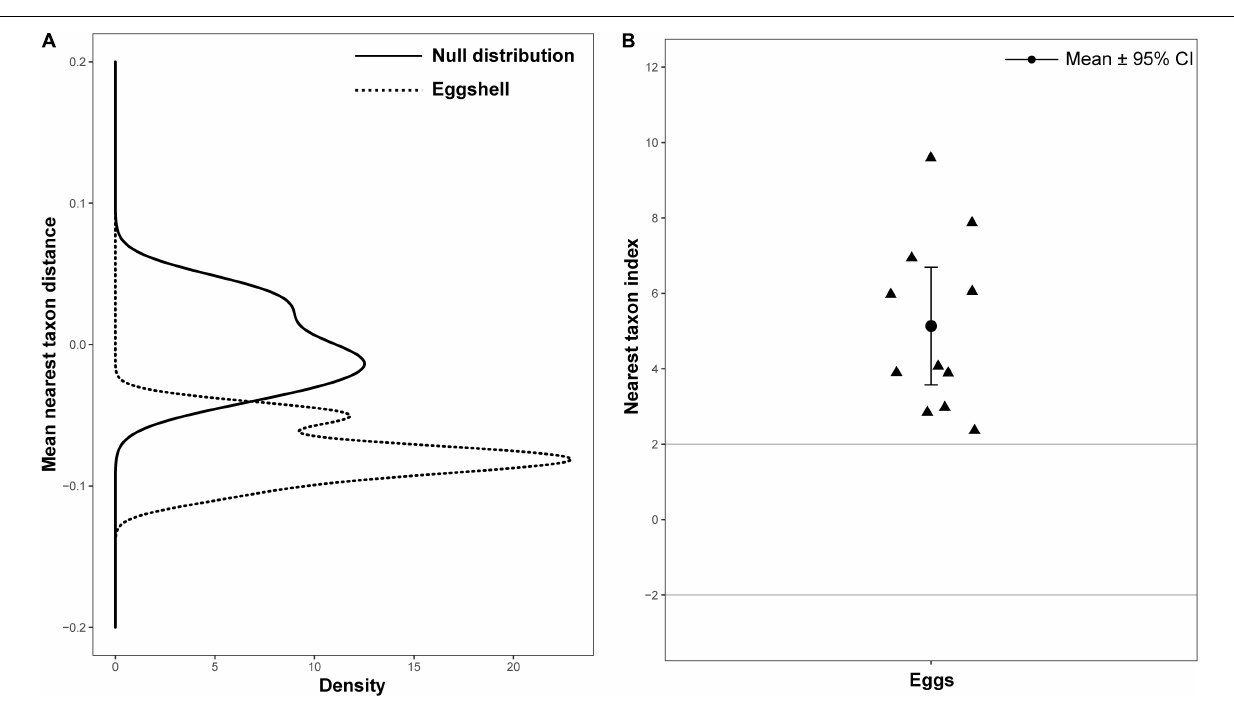
FIGURE 5 | Bacterial community phylogenetic structure of eggshell. (A) Mean nearest taxon distance (MNTD) distributions of phylogenetic structure of eggshell bacterial community (dotted line) deviation from null distribution (solid line, with 999 randomizations). (B) Nearest taxon index (NTI) for eggs of Chinese three-keeled pond turtle. Each triangle represents one sample; data are expressed as mean ± 95%